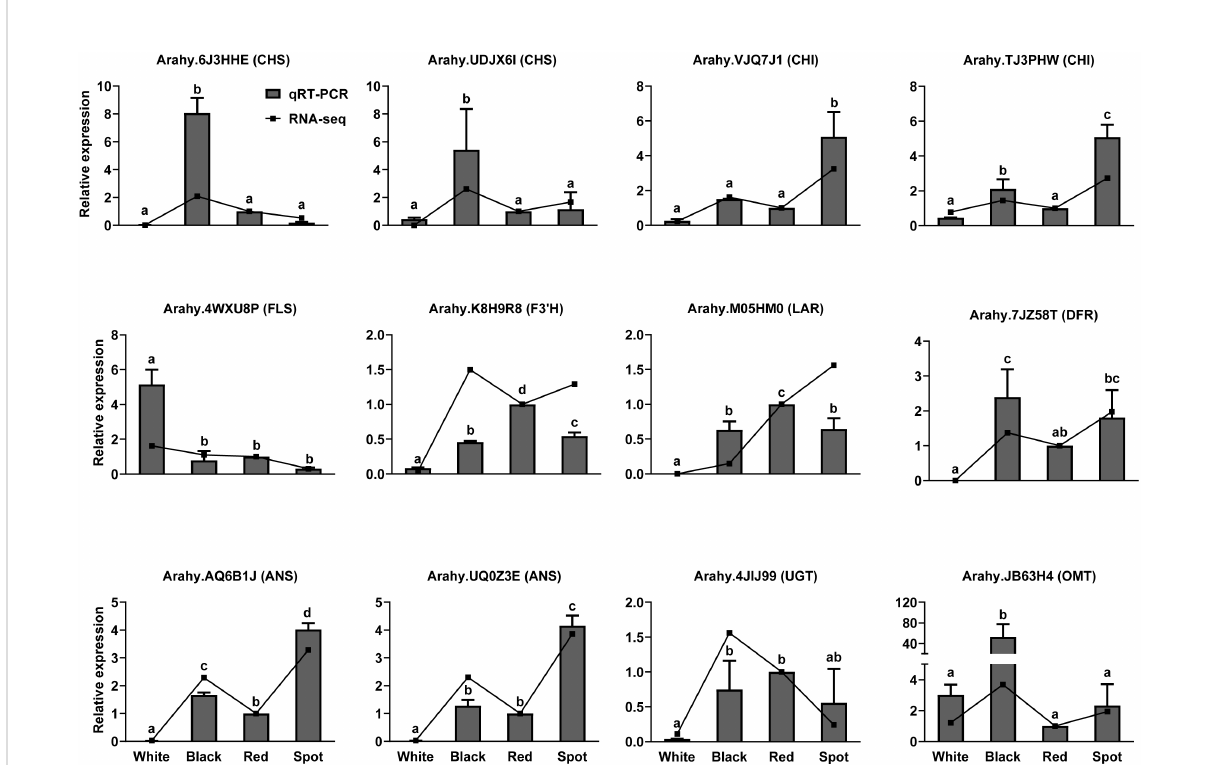
FIGURE 5 Quantitative RT-PCR (qRT-PCR) analysis of the expression levels of key enzyme genes involved in fl avonoid biosynthetic pathway. The relative transcript levels among different samples were quanti fi ed by the 2 - DD Ct method, with A. hypogaea Actin gene as the reference gene for normalization. Multiple comparisons in one-way ANOVA were done by Duncan grouping using SPSS Statistics tool (v22, IBM). Different letters marked in the fi gure represent difference among different peanut cultivars. Error bars indicate the standard deviations of three biological